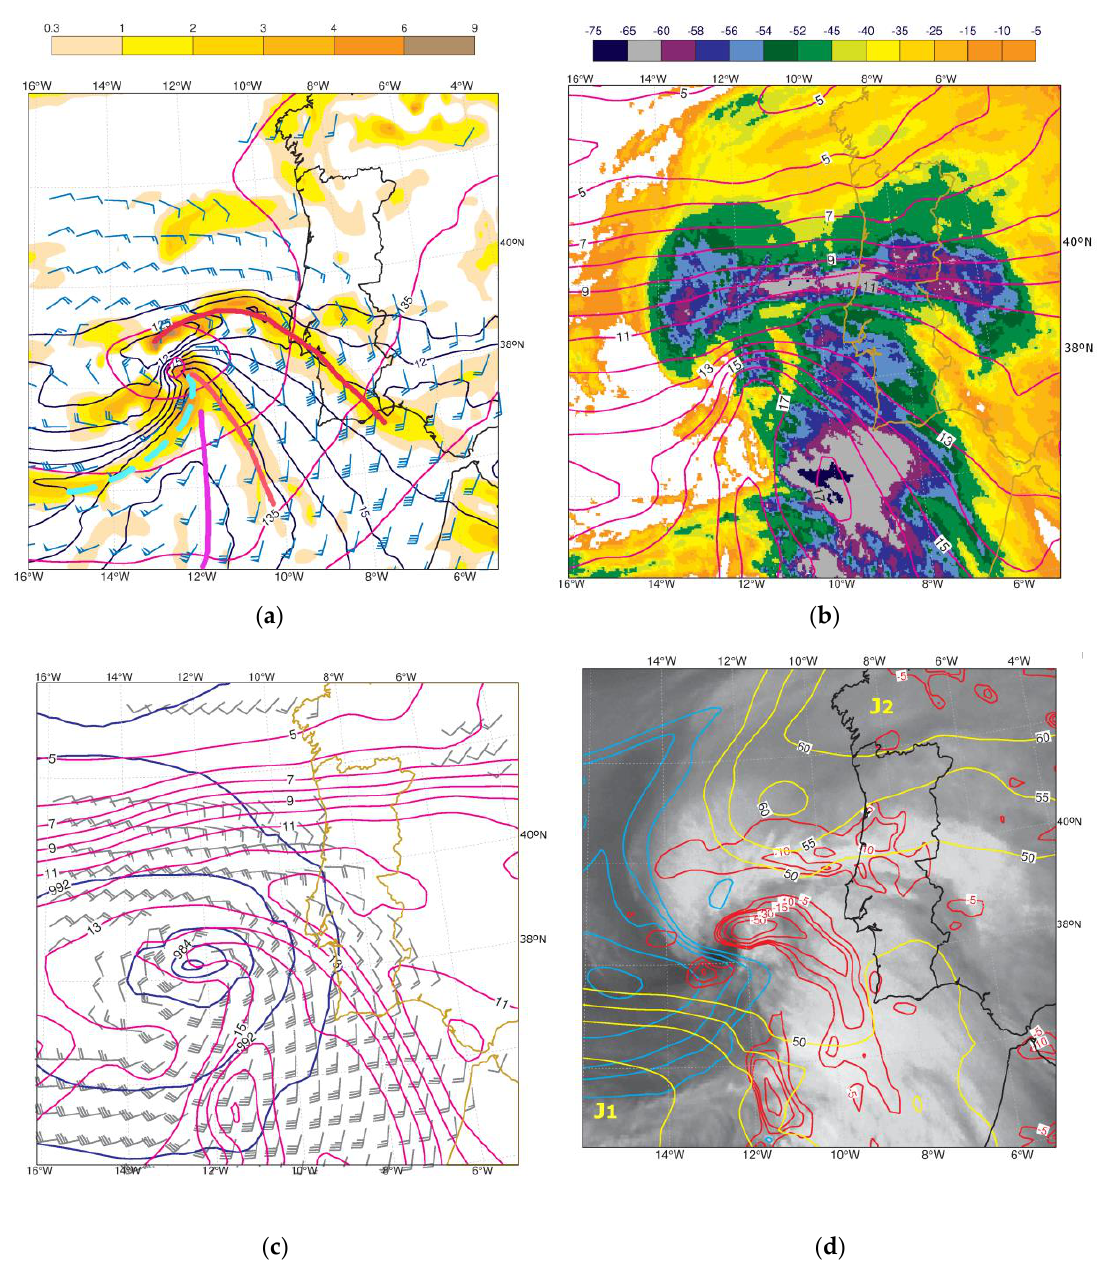
Figure 5. ECMWF analyses and satellite images valid at 00:00 UTC on 23/12/2009. ( a ) Geopotential height at 850 hPa (5 dam intervals, magenta lines), wind (blue barbs) θ w (1 °C intervals, from 11 to 18 °C, black lines) and TFP [°C/(100km) 2 , shaded] at 925 hPa. ( b ) IR10.8 brightness temperature (shaded from −5 to −75 °C) superimposed with 850 hPa θ w (1 °C intervals from 5 to 18 °C, magenta lines). ( c ) MSLP (4 hPa intervals, dark blue lines) and 700 hPa θ w (1 °C intervals from 5 to 18 °C, magenta lines); ( d ) MSG WV6.2 image superimposed with convergence at 850 hPa (−5, −10, −15, −30 and −50 × 10 −5 s −1 , red lines), wind speed at 300 hPa (50, 55, 60 and 70 m s −1 , yellow lines) and potential vorticity at 300 hPa (1, 1.5, 2, 3 and 4 PVU, cyan lines). The SCF (dashed cyan line), UCF (violet line), WF1 and WF2 (red lines) in ( a ). The frontal analysis is based on data from ECMWF and satellite.